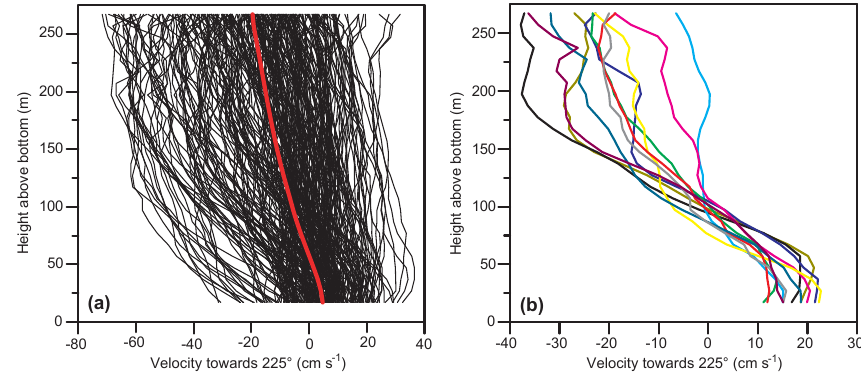
Figure 9. (a) Vertical profiles of U as observed by the ADCP at site B on each day (black lines) and the average profile for the whole deployment period (thick red line). (b) Vertical profiles of U on those days, for which the velocity 47m above the bottom (bin 4) was ≥ 10cms − 1 while the velocity 107m above the bottom (bin 10) was ≤ 0.